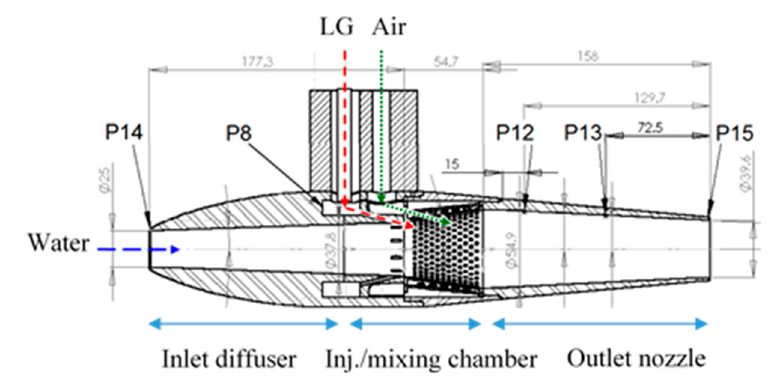
Figure 7. Cross section of the MRJ motor (39.6 mm outlet nozzle shown) enabling either air or LG application. P = pressure readings.